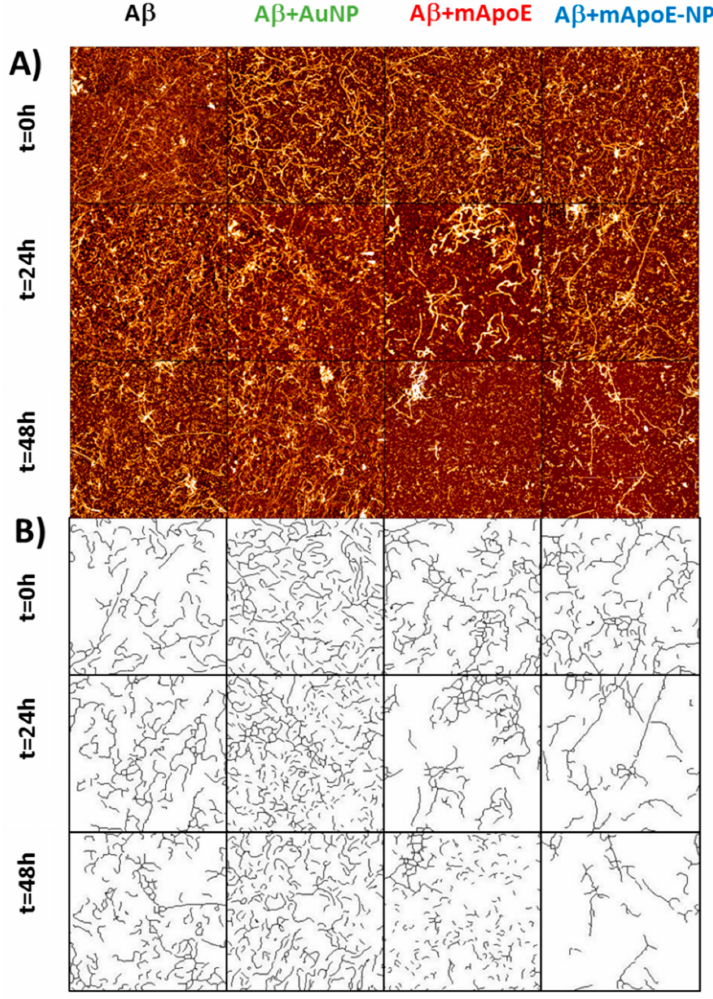
Figure 5. AFM imaging of the e ff ect of external chemical agents (bare AuNP, free mApoE, and AuNP coated with mApoE) on the disaggregation of preformed A β fibrils. ( A ) Representative AFM images of typical disaggregation patterns of preformed A β 1-42 amyloid fibrils (first column), of A β 1-42 amyloid fibrils in presence of AuNP (second column), or free mApoE (third column), or AuNP coated with mApoE (fourth column). Data taken after incubation at 37 ◦ C, at three di ff erent incubation times: t = 0 h (first line), t = 24 h (second line), and t = 48 h (third line). Images of 4 × 4 µ m 2 , 1024 × 1024 pixel, Z-scale 10 nm. ( B ) Post-processed analysis of the AFM images reported in panel A. The lines represent the resulting deposited fibrils as selected by the software procedure indicated in the Materials and